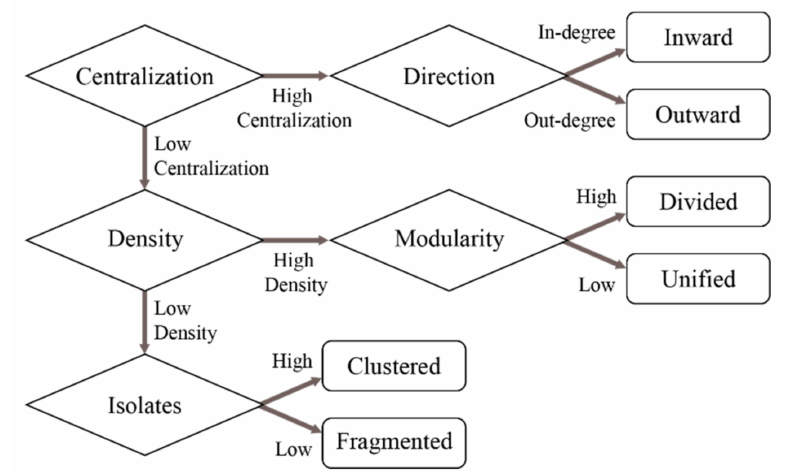
Figure 2. The identification of network types and their assignation procedures [27].